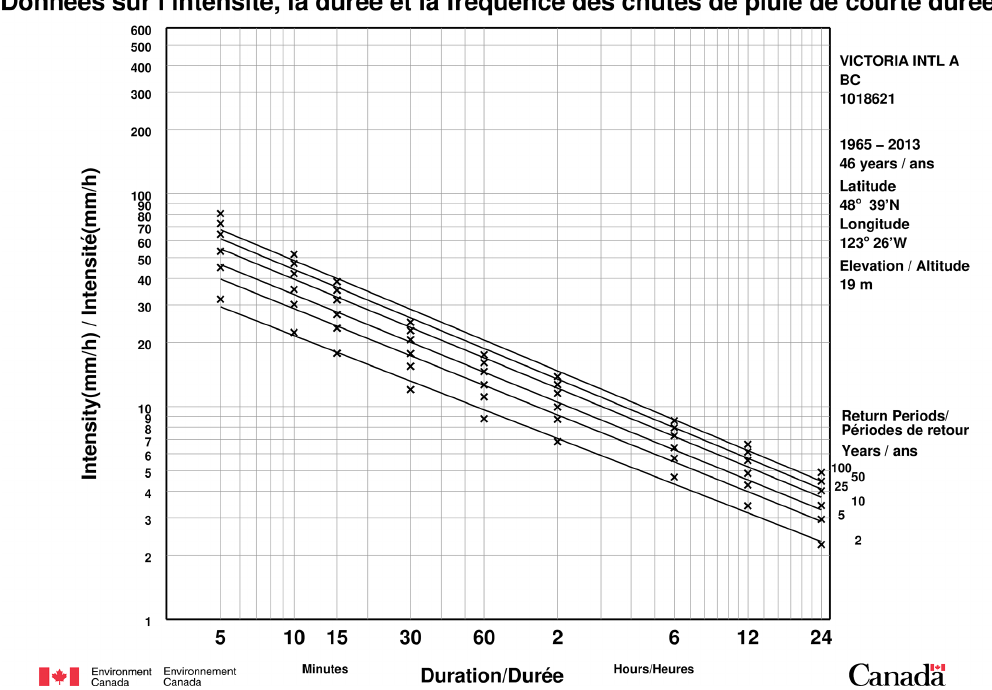
Figure 2. Example ECCC IDF data for Victoria Intl. A. (station 1018621) in British Columbia, Canada. Points (x) show quantiles associated with (from bottom to top) 2-, 5-, 10-, 25-, 50-, and 100-year-return-period intensities estimated by fitting the Gumbel form of the GEV distribution by the method of moments to annual maximum rainfall rate data for 5, 10, 15, 30, and 60min and 2, 6, 12, and 24h durations (left to right). Lines are from best-fit linear interpolation equations between log-transformed duration and log-transformed Gumbel quantiles for each return